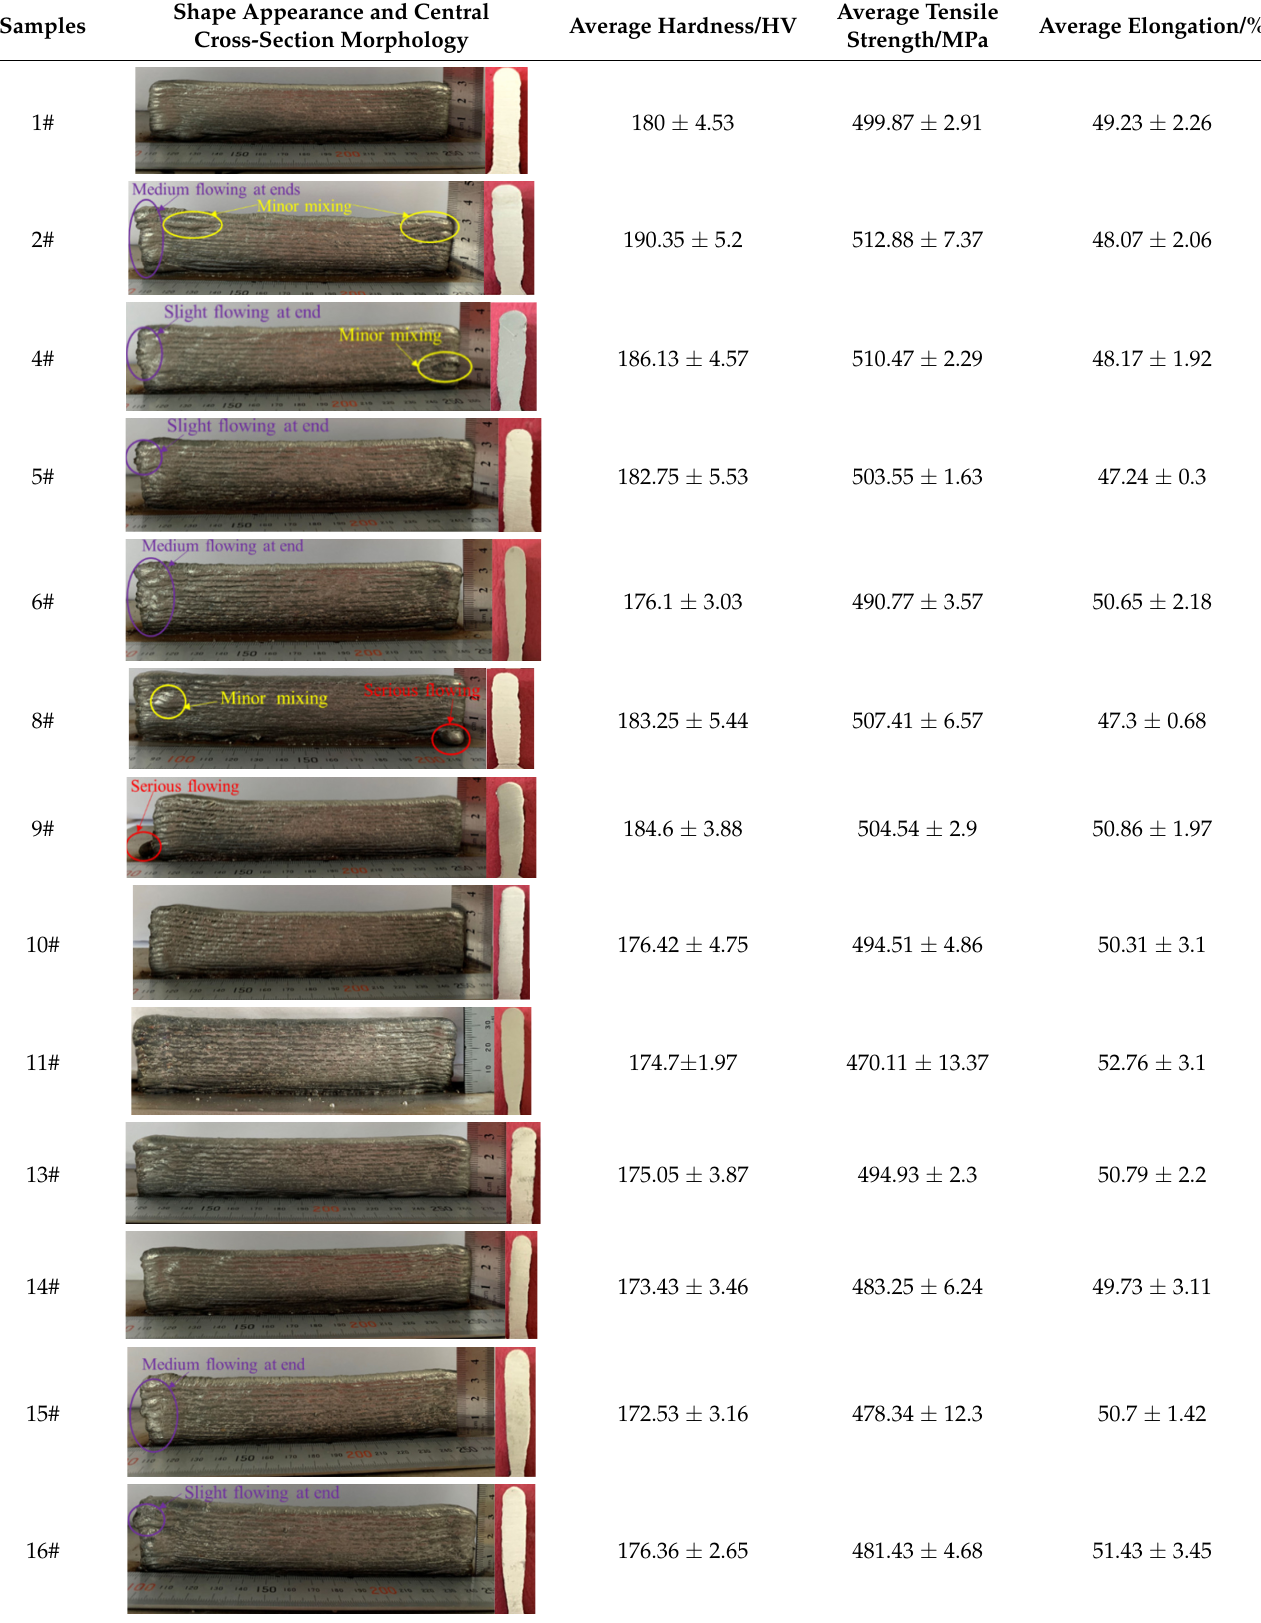
Table 1. Morphologies and properties by BBD response surface experiment (BBD represents Box–Behnken Design).